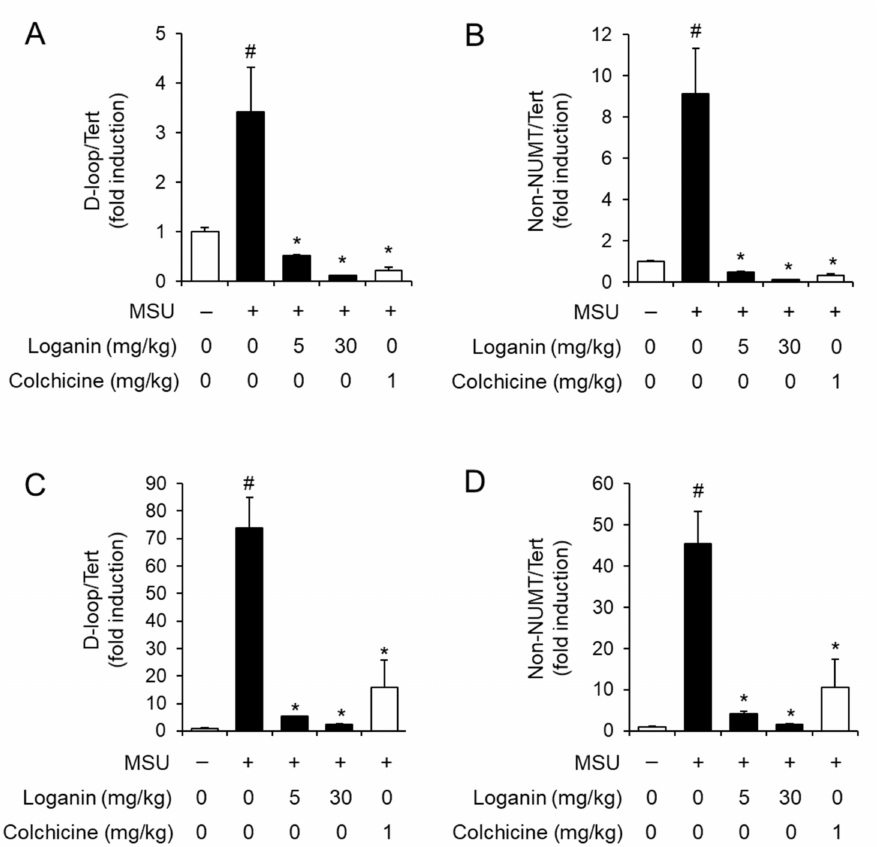
Figure 4. Oral administration of loganin suppresses mitochondrial DNA synthesis in gout